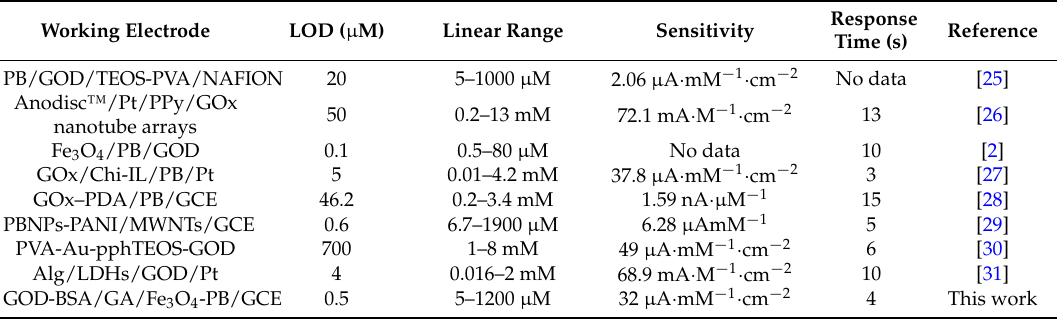
Table 1. Comparison of electrocatalytic activities of this work with the previous reported. Working Electrode